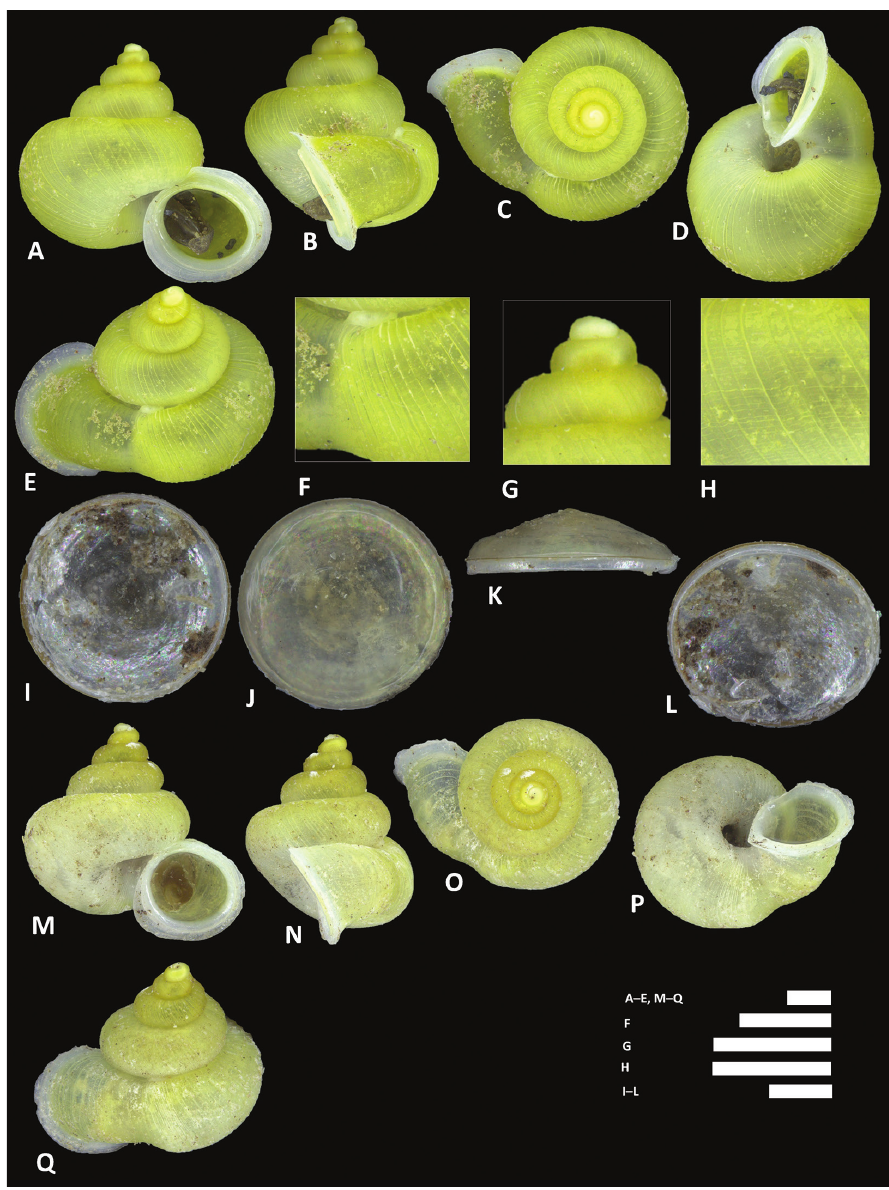
Figure 16. Alycaeus expansus sp. n. A–E Shell of holotype, BOR/MOL 12983 F–H Close up of shell of holotype, BOR/MOL 12983 I–L Operculum of holotype, BOR/MOL 12983 M–Q Shell of BOR/MOL 245. Scale bars: A–H 1 mm; I–L 0.5 mm. All photographs by Junn Kitt Foon . Etymology. Latin, meaning expanded. In reference to the very expanded peri- stome and globose whorls. Description. Protoconch.